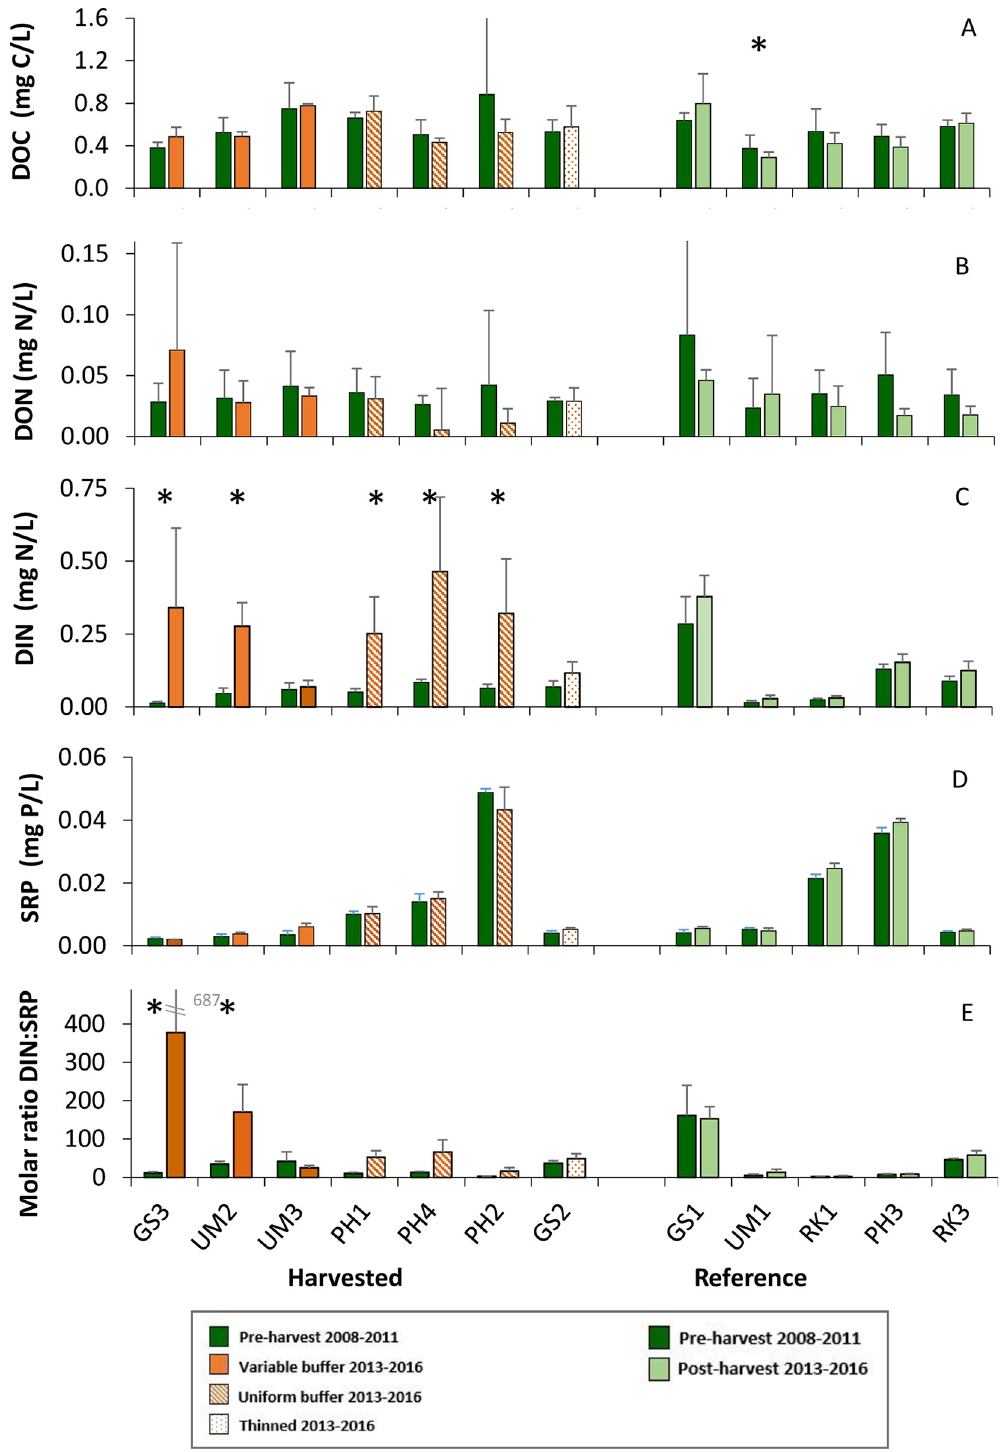
Fig 4. Average concentrations of dissolved nutrients and carbon at headwater sites. Sites are organized from left to right by percentage of overstory light reaching the stream post-harvest. A) Dissolved organic carbon (DOC), B) Dissolved organic nitrogen (DON). C) Dissolved inorganic nitrogen (DIN), D) Soluble reactive phosphorus (SRP), E) Molar ratios of DIN:SRP. Bars show averages plus standard deviation during early summer annual sampling. Asterisks indicate that watershed values were significantly different using PLS analyses (Table